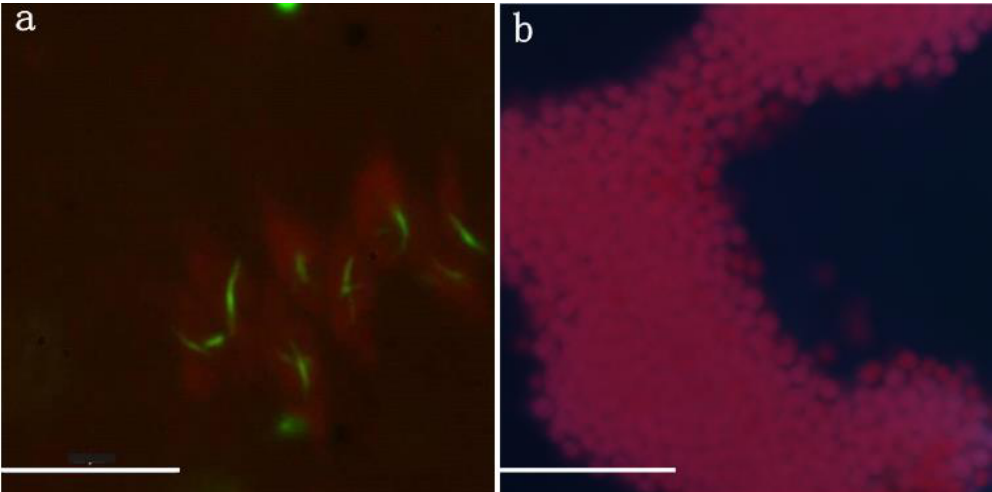
Figure 5. Sediment P fractionations before and after water diversion in Lake Yuehu. Asterisks (*) indicate significant difference ( P < 0.05).